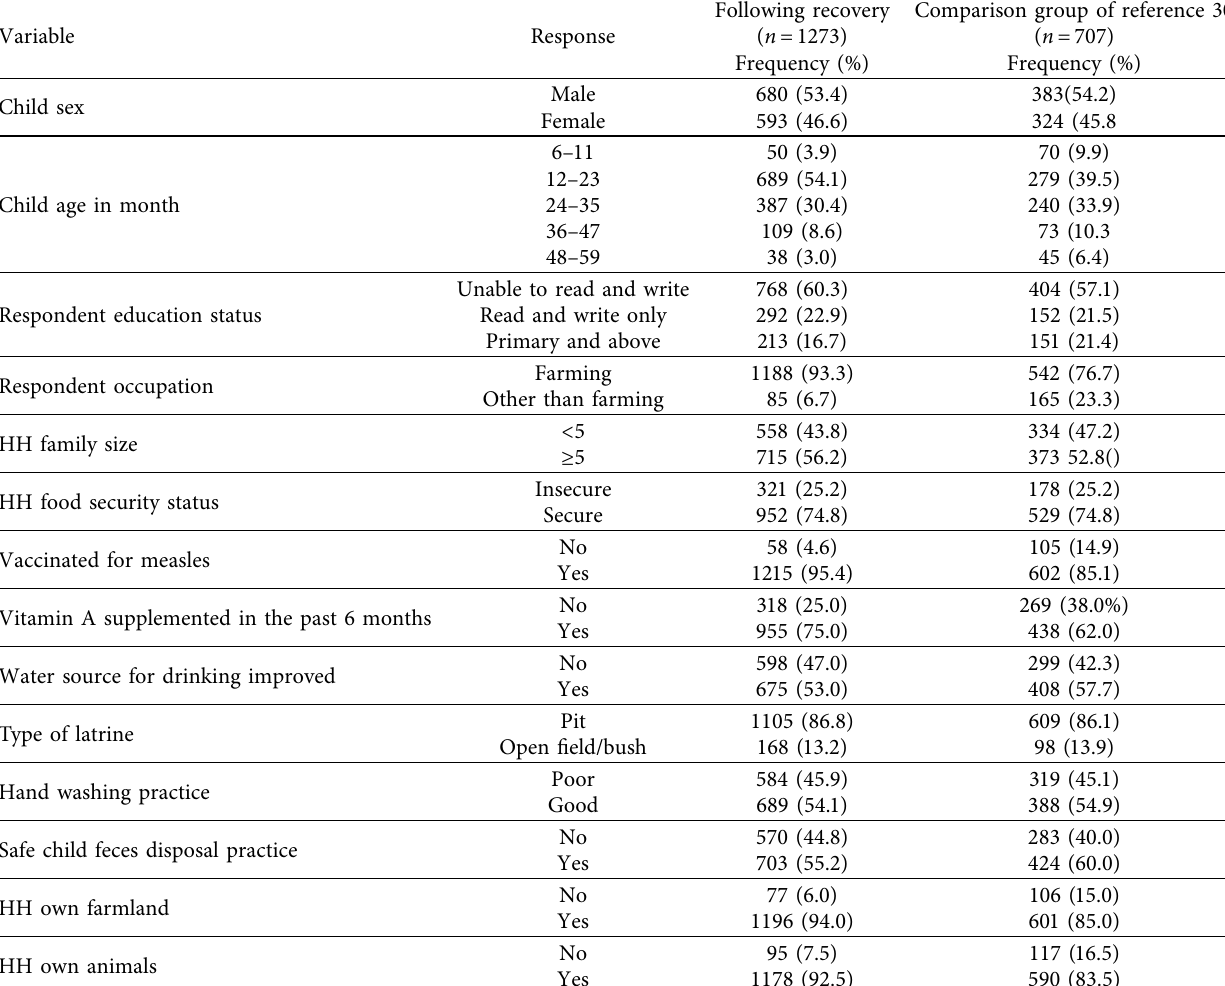
Table 2: Some of the epidemiologic variables from the two parent studies [29,